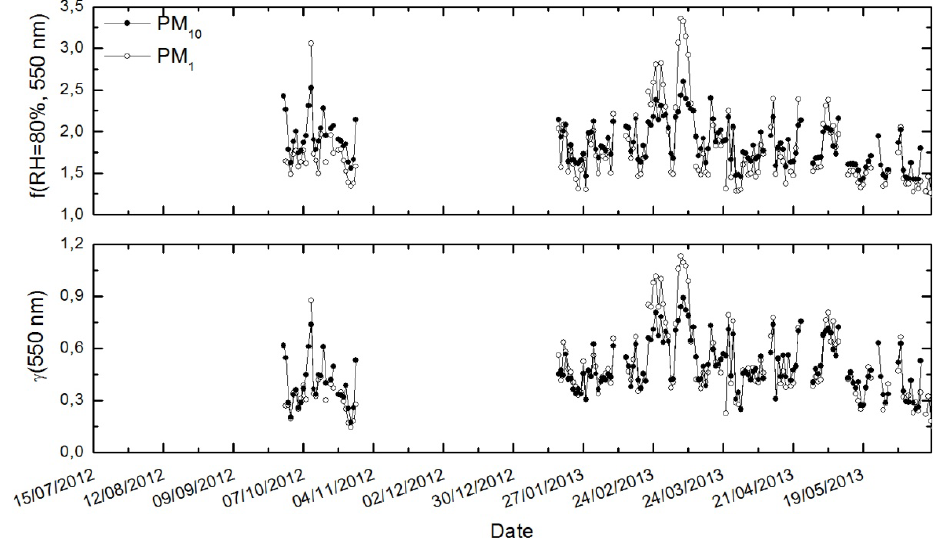
Figure 2. Temporal evolution of the daily scattering enhancement factor at 80% relative humidity (upper panel) and the fit parameter γ (lower panel), for PM 10 and PM 1 fractions. The date is in the format dd/mm/yyyy.